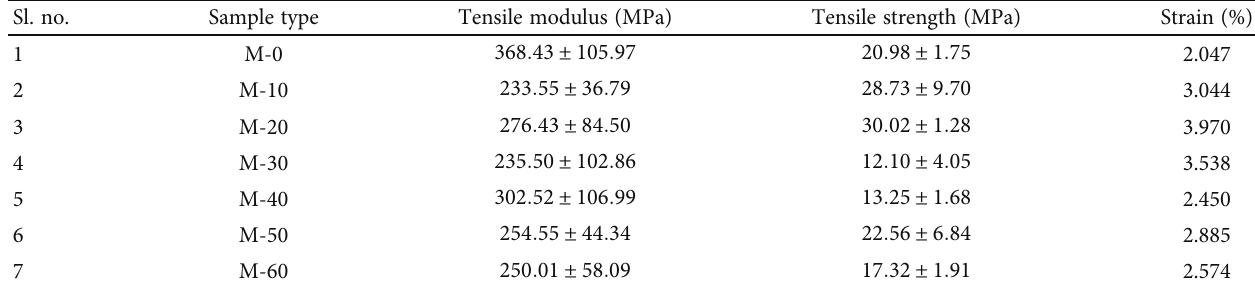
Table 3: Tensile properties of mango seed shell/epoxy composites.